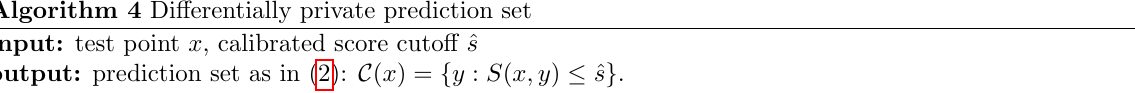
Algorithm 4 Differentially private prediction